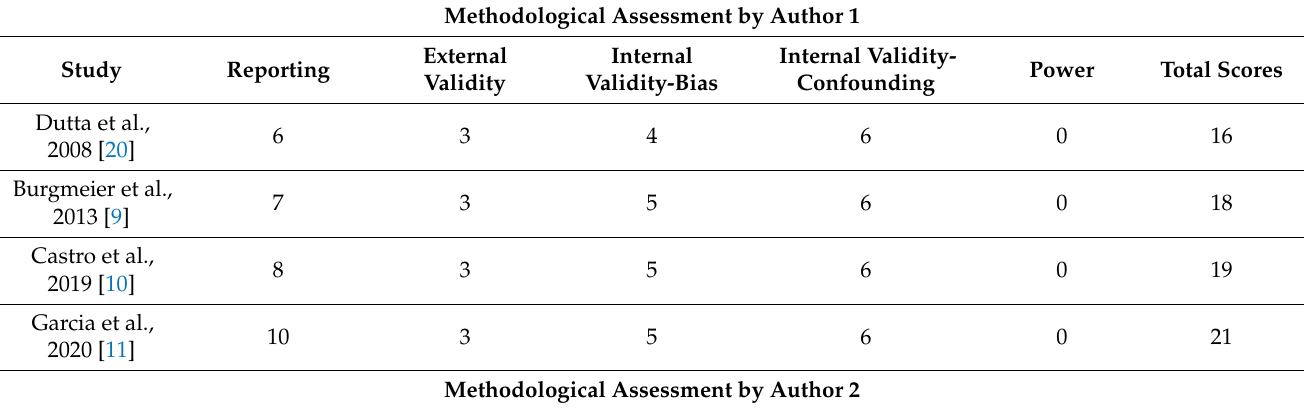
Table 2. Downs and Black scale scores for the included studies by author 1 and author 2. The total scores and inter-observer agreement are also depicted in the